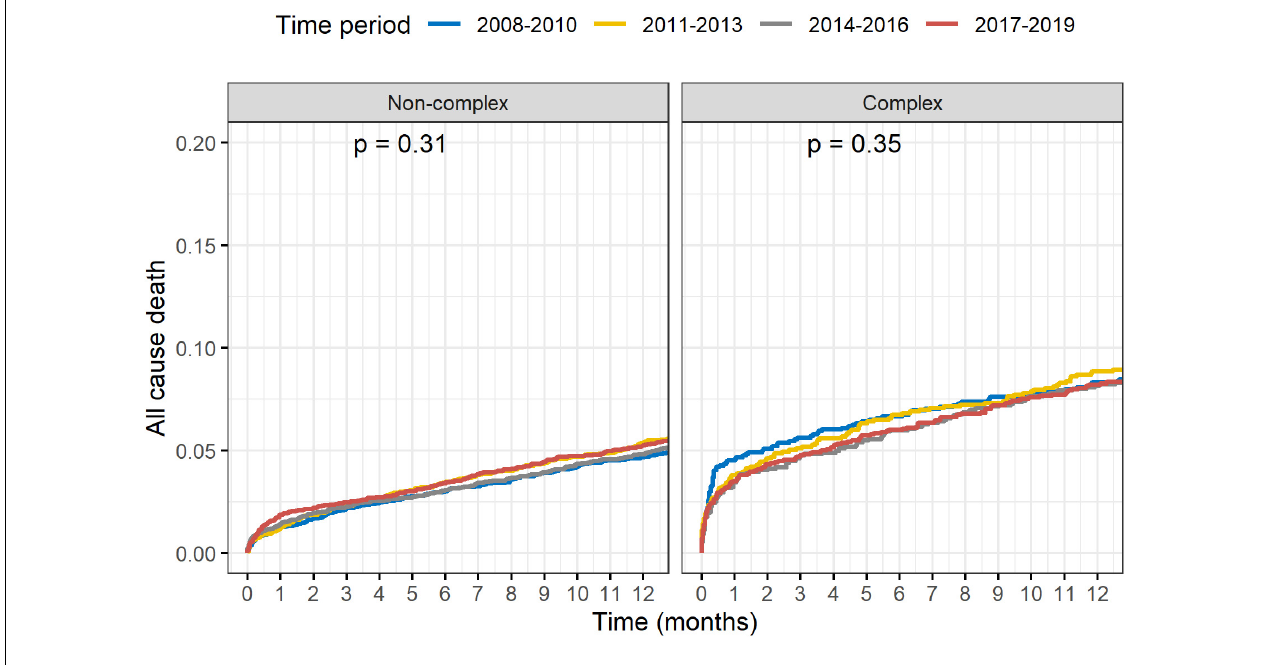
FIGURE 6 | Complex vs. non-complex (per time period death). TABLE 4 | Complex PCI—temporal outcomes.